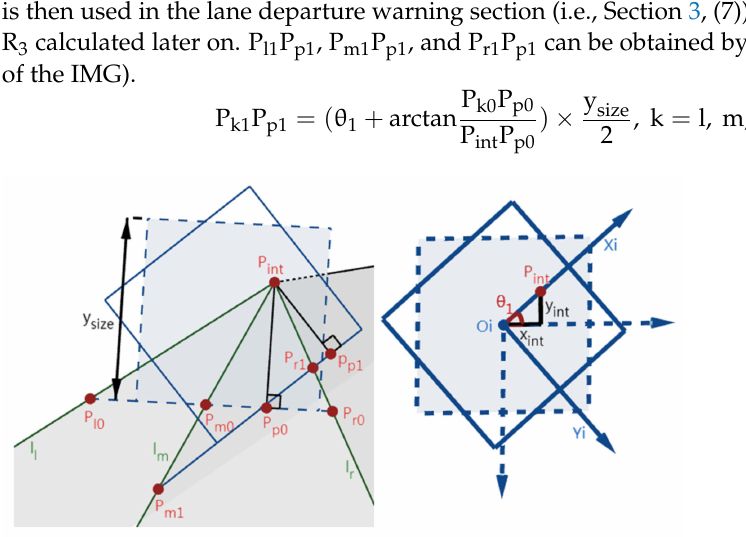
Figure 5. The imaging differences before and after step